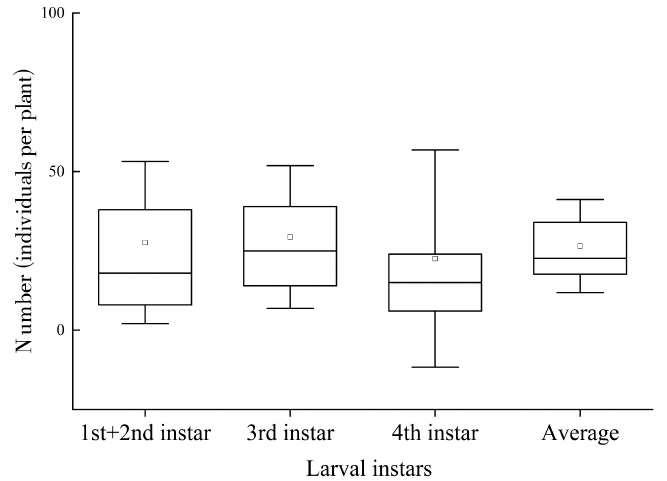
Figure 3. Number of specimens of C. aeruginosa larval instars (individuals per plant). Horizontal lines represent median value; circles represent average values; boxes represent upper and lower quartiles; vertical bars represent standard deviations.